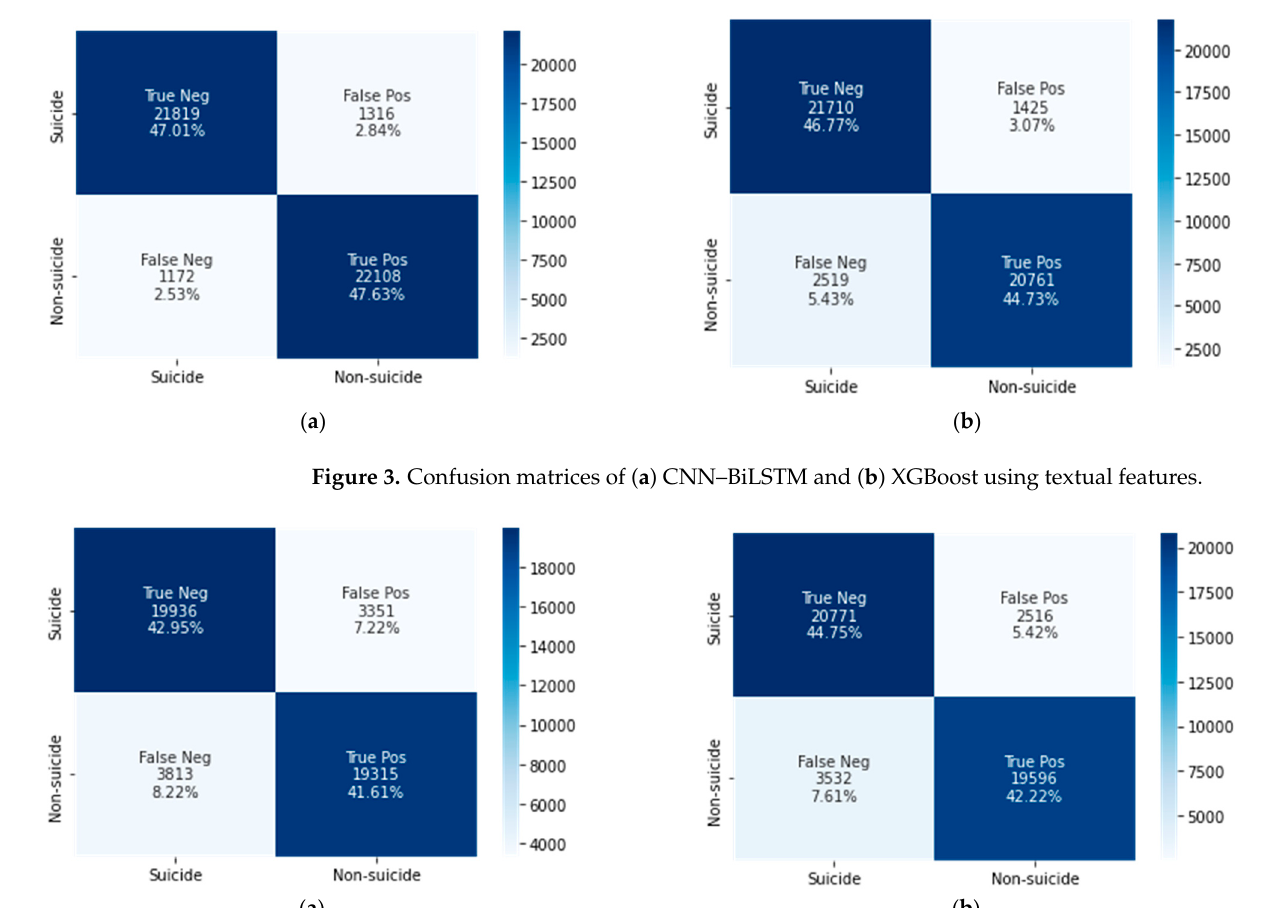
Figure 4. Confusion matrices of ( a ) CNN–BiLSTM and ( b ) XGBoost using LIWC features Table 3. Test results using textual features.